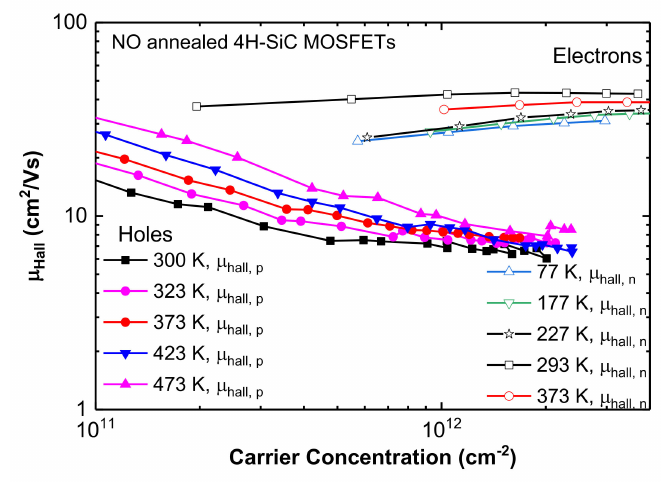
Figure 3. Typical Hall mobility as a function of carrier concentration at different temperatures for n- and p-channel MOSFETs with channel width 60 µ m and channel length 600 µ m for both kinds of Hall bar MOSFET, and V ds was set to 0.75 V.